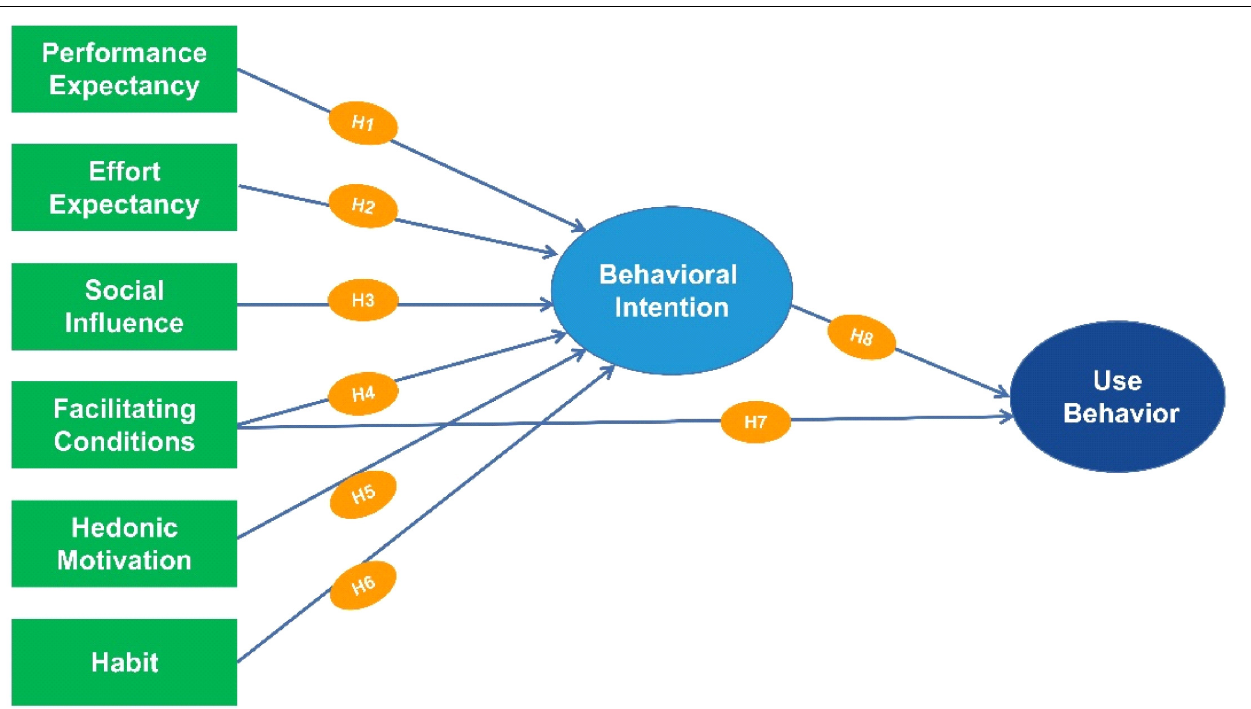
FIGURE 3 | Proposed model based on UTAUT-2 (Venkatesh et al.,